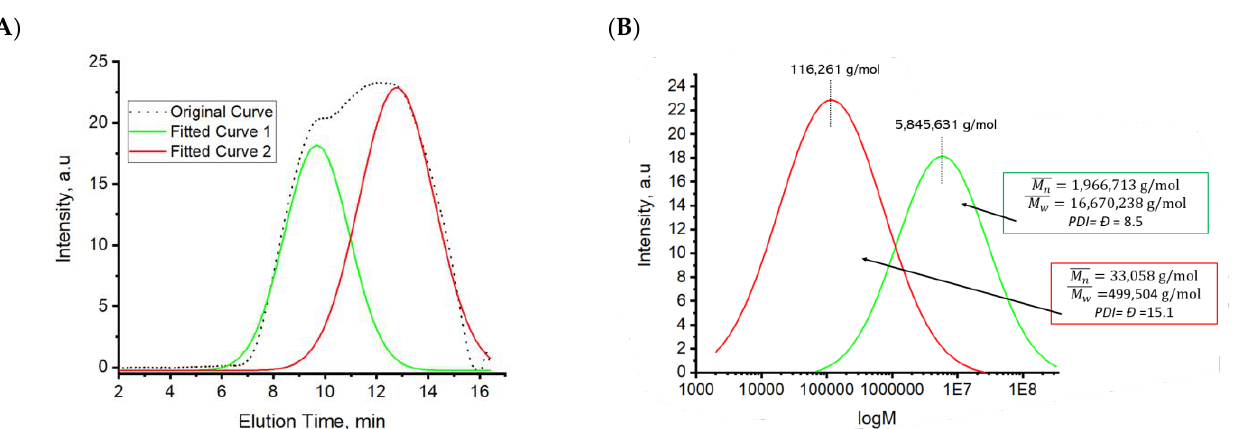
Figure 4. GPC analysis of PBBM-X: ( A ) The original GPC trace deconvoluted into two fractions, and ( B ) the intensity versus molecular weight for the fractions.